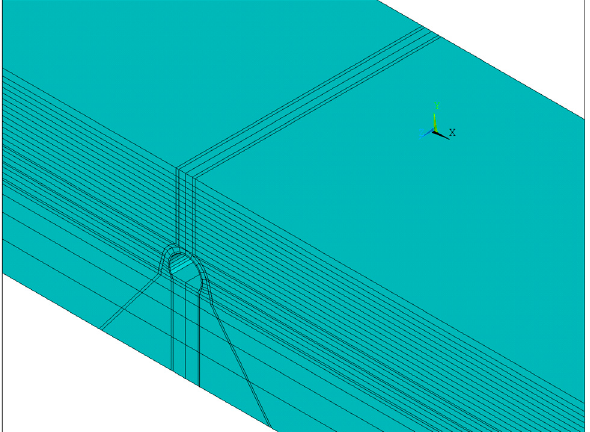
Figure 14. Three-dimensional finite element model for a numerical simulation from ANSYS 12.0 software.